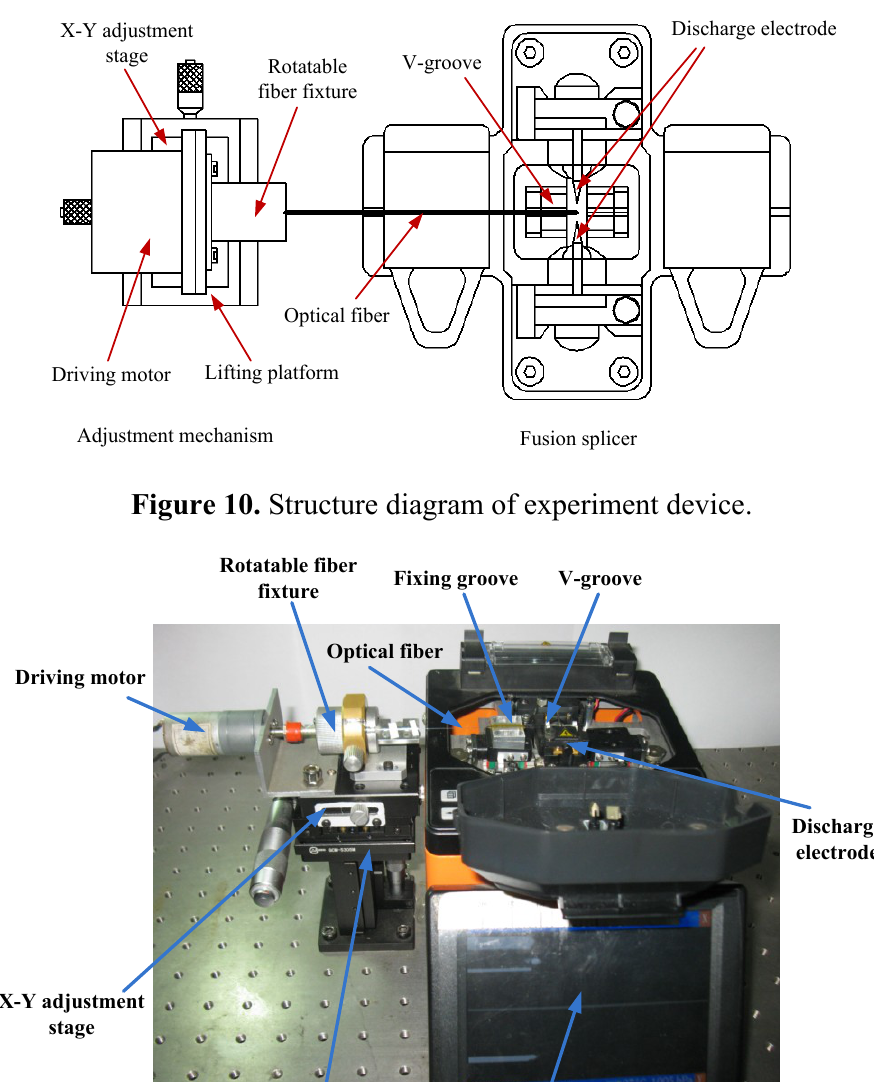
Figure 9. Schematic diagram of experiment device.